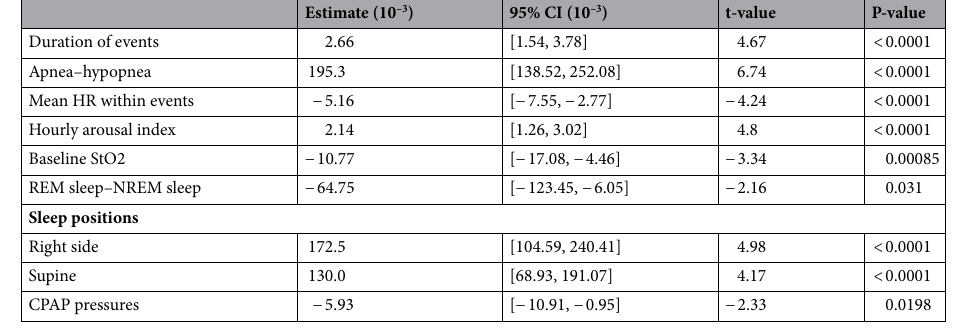
Table 2. The outcomes of the linear mixed-effects model of the CV-BV changes. Confidence interval (CI). Heart rate (HR). Rapid eye movement sleep (REM). Non-REM sleep (NREM). Continuous positive airway pressure (CPAP). The change in apnea is the reference for the change in hypopnea in this model. Sleep on left side is the reference for sleep on right side and on supine position. NREM sleep is the reference for REM sleep. Hourly arousal index is the arousal index calculated in each hour.